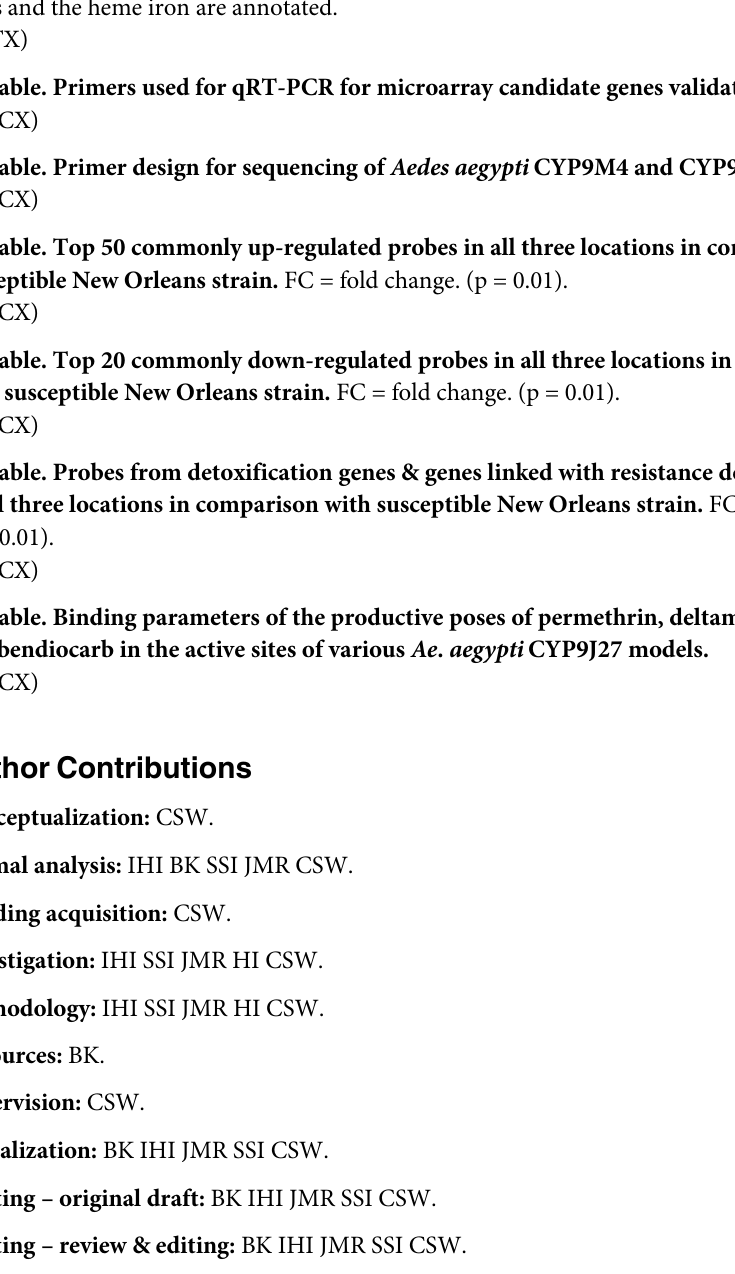
S9 Fig. Binding conformation of (A) permethrin, (B) deltamethrin, (C) DDT and (D) bendio- carb in KB CYP9J27 model. Distances between the probable sites of attack on various insecti- cides and the heme iron are annotated. S1 Table. Primers used for qRT-PCR for microarray candidate genes validation. S2 Table. Primer design for sequencing of Aedes aegypti CYP9M4 and CYP9J27. S3 Table. Top 50 commonly up-regulated probes in all three locations in comparison with susceptible New Orleans strain. FC = fold change. (p = 0.01). S4 Table. Top 20 commonly down-regulated probes in all three locations in comparison with susceptible New Orleans strain. FC = fold change. (p = 0.01). S5 Table. Probes from detoxification genes & genes linked with resistance down-regulated in all three locations in comparison with susceptible New Orleans strain. FC = fold change.